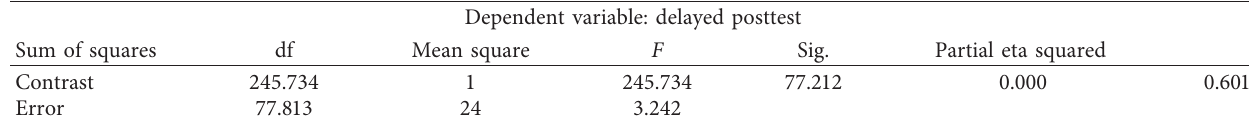
Table 10: Univariate tests.